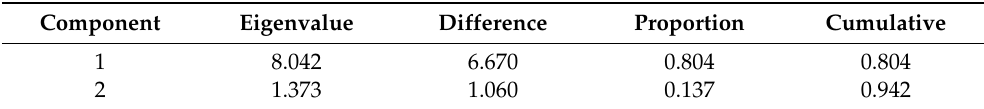
Table 2. Eigenvalues and variance explained by the first two principal components for the quality parameters of EVOOs.